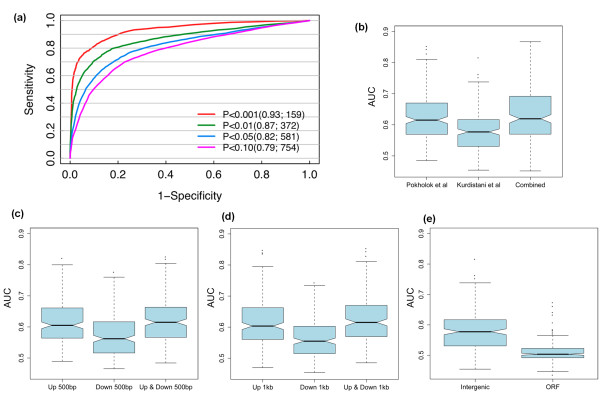
Model parameters. (a) Stricter thresholds for target gene calling result in better predictions. (b) Combination of independent histone modification data sets can improve target predictions. Predictions for 203 TFs are evaluated by area under the receiver operator characteristic (ROC) curve (AUC) for data from Pokholok et al. [23] and Kurdistani et al. [22]. (c, d) Using histone modifications within a 500-bp (c) and 1, 000-bp (d) window upstream and downstream of ATG sites of target genes achieves a similar performance to using only upstream signals, and better performance to using only downstream signals. There was no significant performance difference between using 500-bp and 1, 000-bp window sizes. (e) Using histone modifications in intergenic regions has better predictive power than using those in ORF coding regions.